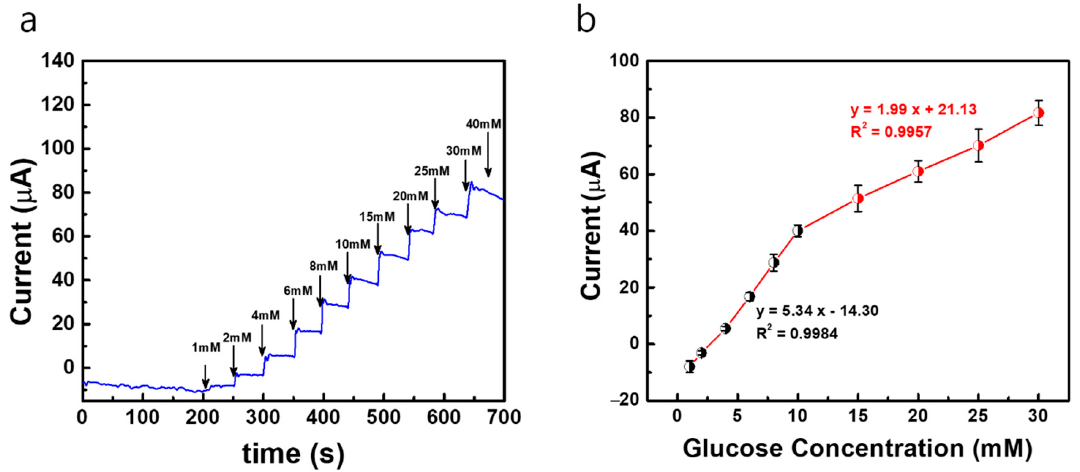
Figure 7. ( a ) Constant potential amperometric current response curves ( i vs. t ) of AuMN/Pt-black/Nf electrode array measured using the fabricated wireless non-invasive CGM system at a fixed external applied potential of +0.12 V vs . AgCl MN and Pt-black-deposited MN as counter electrode in a background electrolyte of 100 mM PBS with successive step-wise addition of glucose from 1 mM → 40 mM; ( b ) the linear fitting curves for the current responses measured with the correlation co-efficient values (R 2 ) and linear regression equations. The measured data are presented as the av- erage of three independent experiments (n = 3) with the range represented as standard error.